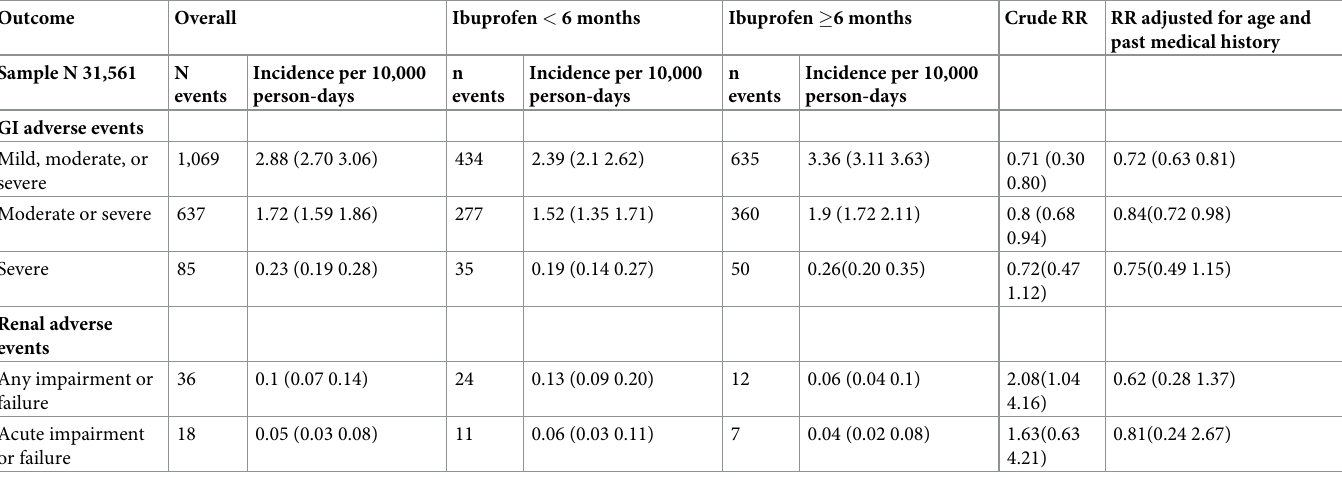
Table 5. Hypothesis 1 at six-month follow up.